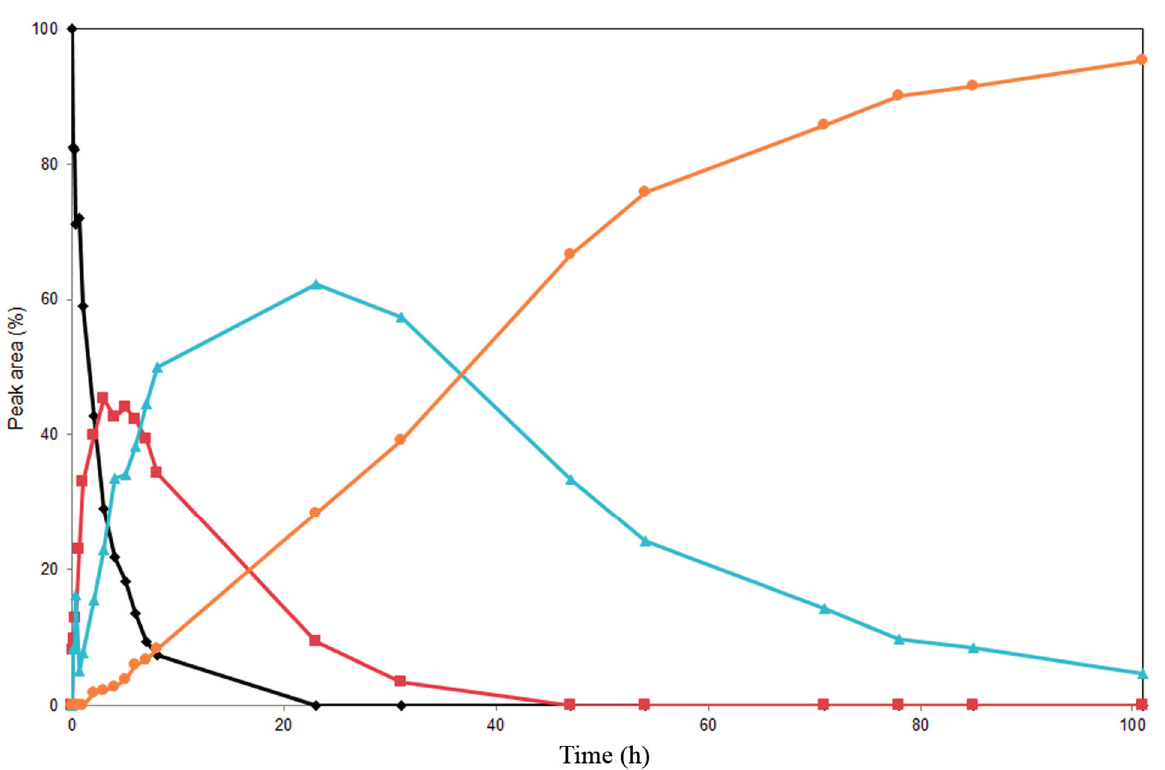
Figure 4. Time course study of the alcoholysis of silychristin peracetate ( 3 ,  ) at 45 °C in MTBE/ n -butanol catalyzed by lipase PS immobilized on diatomite. Products (3,5,15,19, 22-penta- O -acetyl silychristin, 4 ,  ), (3,15,19,22-tetra- O -acetyl silychristin, 5 , ▲ ) and (3,15,22-tri- O -acetyl silychristin, 6 , 